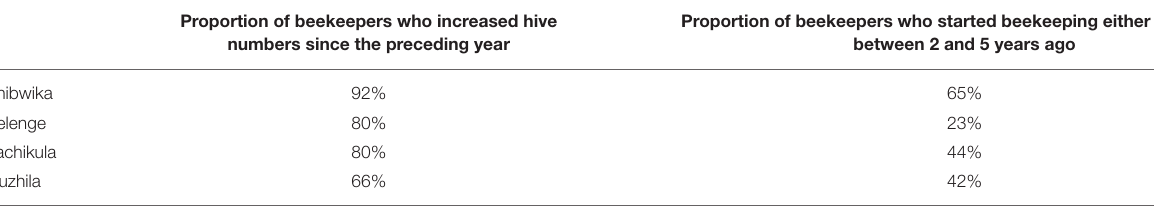
TABLE 6 | Site by site results about hive increasing and adoption rates. Proportion of beekeepers who increased hive numbers since the preceding year